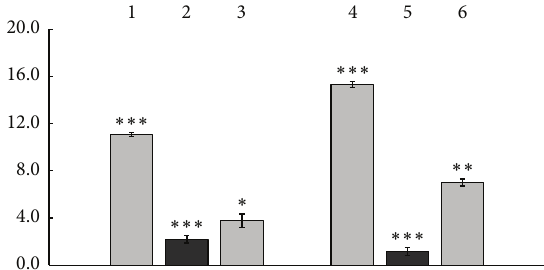
∗∗∗∗∗ ∗∗∗∗∗∗∗∗∗ Figure 2: Production of G-CSF by normal human PBC induced Figure 3: Production of VEGF by normal human PBC induced with human serum 𝛾 -globulin metal complexes formed with copper with human serum 𝛾 -globulin metal complexes formed with copper or zinc ions, with control 𝛾 -globulins, and with copper and zinc ions or zinc ions, with control 𝛾 -globulins, and with copper and zinc used alone ( 𝑀 ± 𝑚 , 𝑛 = 8 ). Induction for 48 hrs at 37 ∘ C. In the ions used alone ( 𝑀 ± 𝑚 , 𝑛 = 8 ). Induction for 48hrs at 37 ∘ C. ordinate axis: concentration of G-CSF, pg/ml. ∗ 𝑃 < 0.1 compared In the ordinate axis: concentration of VEGF, pg/ml. The absciss with 𝛾 -globulin complex formed with zinc ions (2); ∗∗ 𝑃 < 0.01 axis is conducted from the concentration of 200.0 pg/ml. ∗ 𝑃 < 0.1 compared with zinc ions used alone (3); ∗∗∗ 𝑃 < 0.001 compared compared with control 𝛾 -globulin for the zinc complex (1); ∗∗ 𝑃 < 0.05 compared with 𝛾 -globulin complex formed with zinc ions (2); with zinc ions used alone (3) or with control 𝛾 -globulin for the zinc ∗∗∗ 𝑃 < 0.001 comparedwithcontrol 𝛾 -globulinforthezinccomplex complex (1), as well as compared with copper ions used alone (6) or with control 𝛾 -globulin for the copper complex (4) and with copper (1) and with zinc ions used alone (3), as well as being compared with ions used alone (6). control 𝛾 -globulin for the copper complex (4) and with copper ions used alone